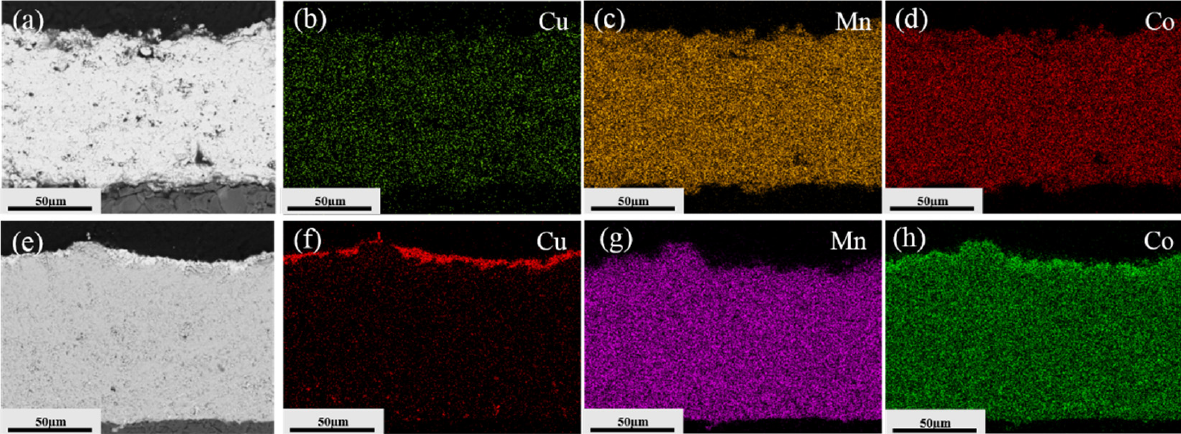
Figure 12. Morphologies and compositions of Cu 0.3 Mn 1.5 − x Co 1.5 − y O 4 coating: ( a – d ) before the conductivity measurement; ( e – h ) after the conductivity measurement.